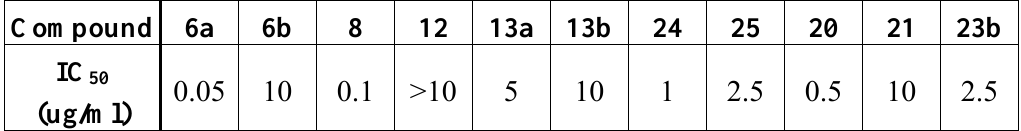
Table 2. In- vitro cytotoxicity against P-388 mouse lymphoma